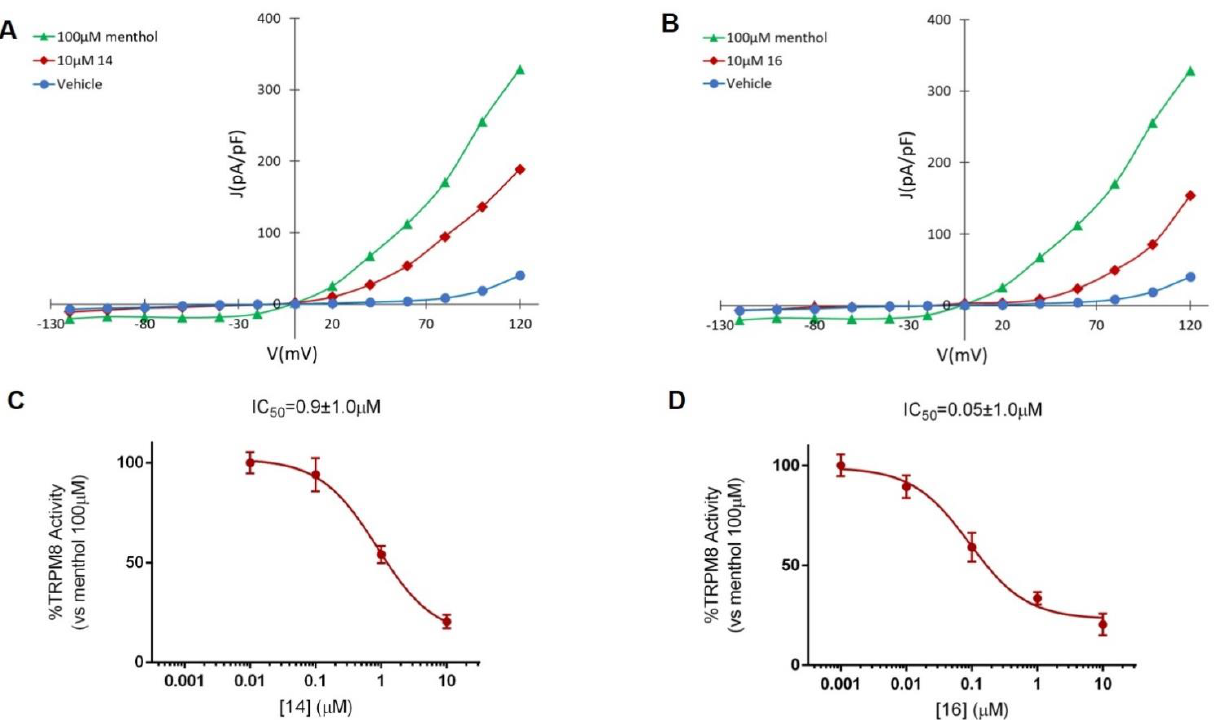
Figure 2. Compounds 14 and 16 block TRPM8-mediated responses evoked by menthol in rTRPM8-expressing HEK293 cells. ( A , C ). I – V curves obtained in HEK293 cells expressing TRPM8 and exposed to vehicle solution (vehicle; blue traces), 100 μM menthol (green trace), 100 μM menthol + 10 μM 14 (red trace) or to 100 μM menthol + 10 μM compound 16 (red trace). Peak current data were expressed as pA/pF (to facilitate comparison among cells of different sizes) and expressed as a function of antagonist concentrations. ( B , D ), Concentration/response curves for TRPM8 current blockade by compound 14 ( C ) or compound 16 ( D ) at a holding voltage of − 60 mV. The solid lines represent fits of the experimental data to the following binding isotherm: y = max/(1 + x/IC50)n, where x is the drug concentration and n the Hill coefficient. The fitted values for IC 50 were 0.9 ± 1.0 and 0.05 ± 1.0 for compound 14 and 16 , respectively. Each point is the mean ± SEM of 15 determinations, each obtained in different cells. Table 3. Patch-clamp experiments (whole cell configuration in HEK293 cells expressing TRPM8